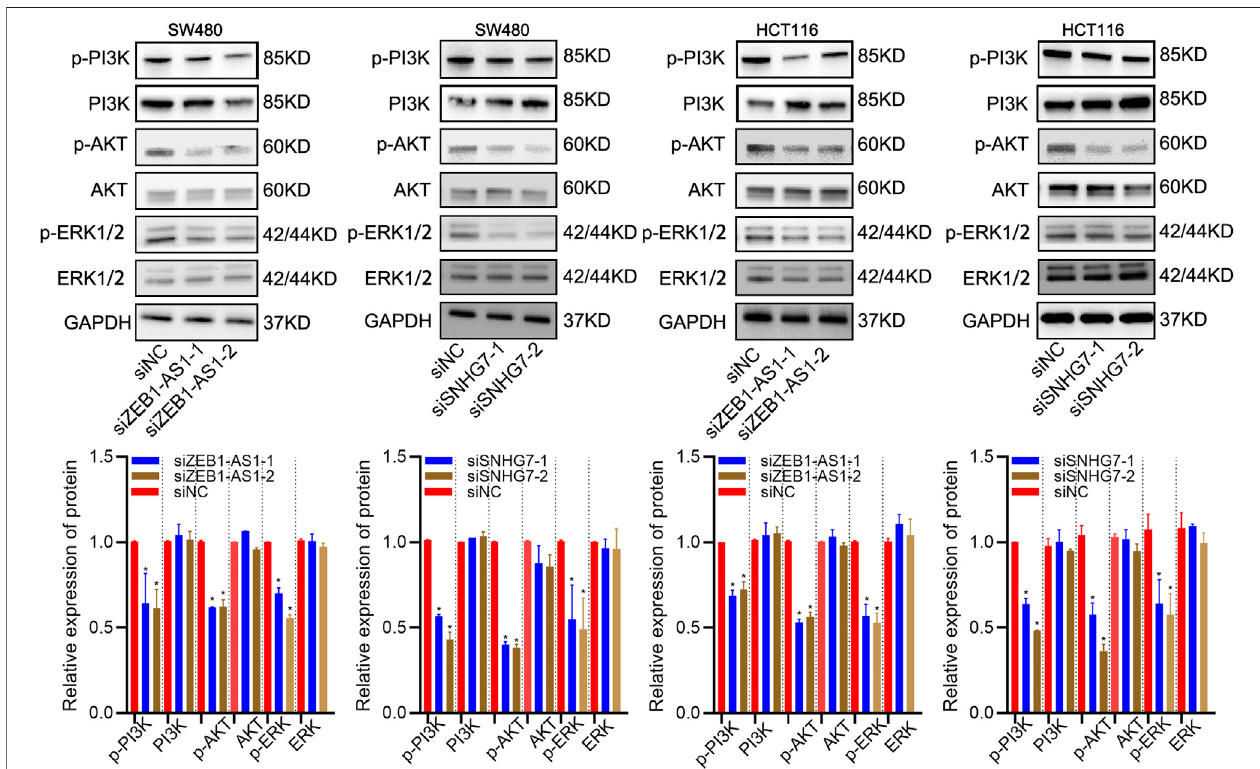
FIGURE 13 | ZEB1-AS1 and SNHG7 modulated ERK/PI3K/AKT pathways. WB analysis suggested that ZEB1-AS1 and SNHG7 knockdown signi fi cantly decreased the levels of phospho-Akt (p-AKT), phospho-PI3K (P-I3K), and phospho-ERK